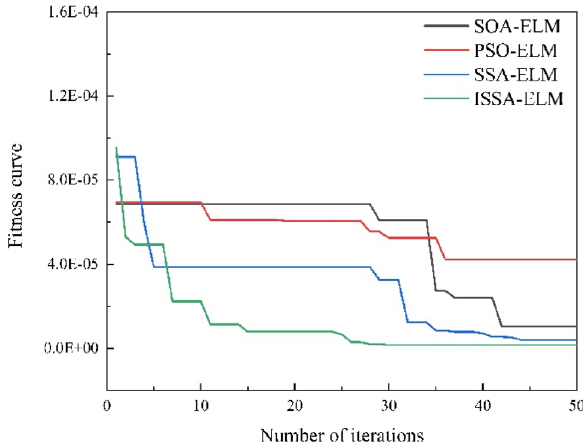
Figure 9. Comparing the fitness curves of different models.